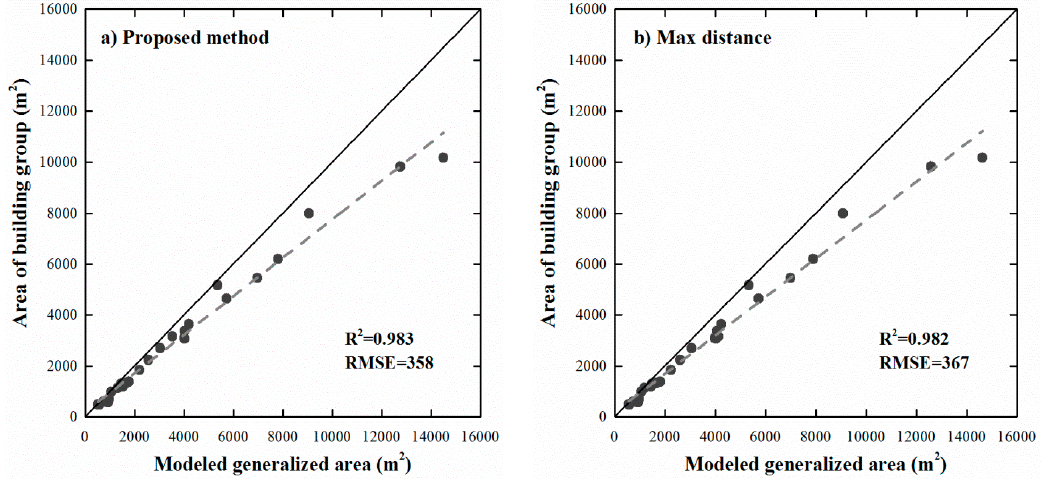
Figure 8. Regressions between the areas of building clusters and the areas of modelled generalized objects that were derived from ( a ) the proposed method; and ( b ) the method by using the maximum distance of each building cluster.